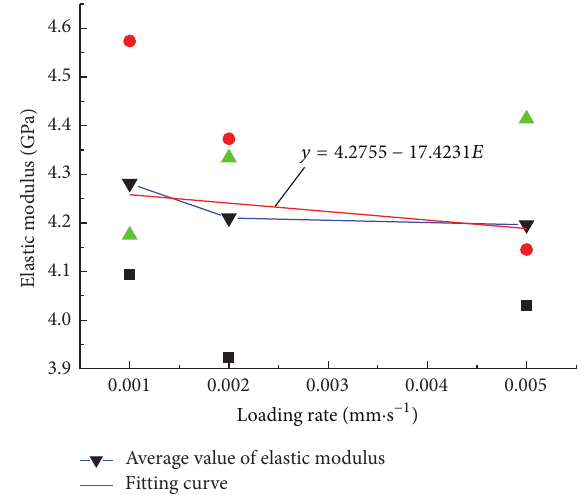
Figure 6: The relationship between elasticity modulus and loading